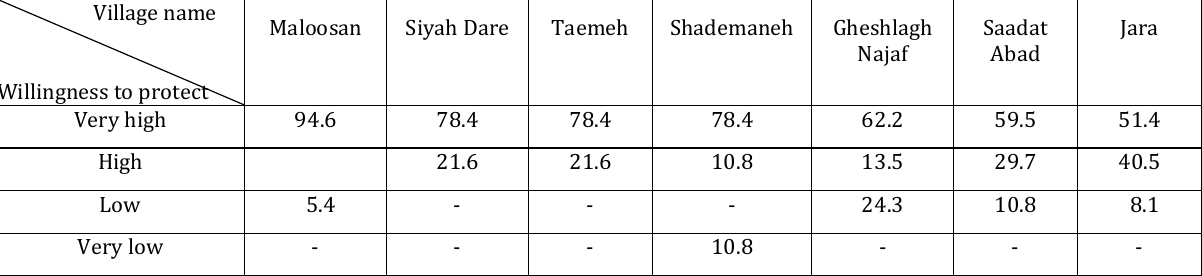
Table 6. Willingness to protect the environment in the study area [%]